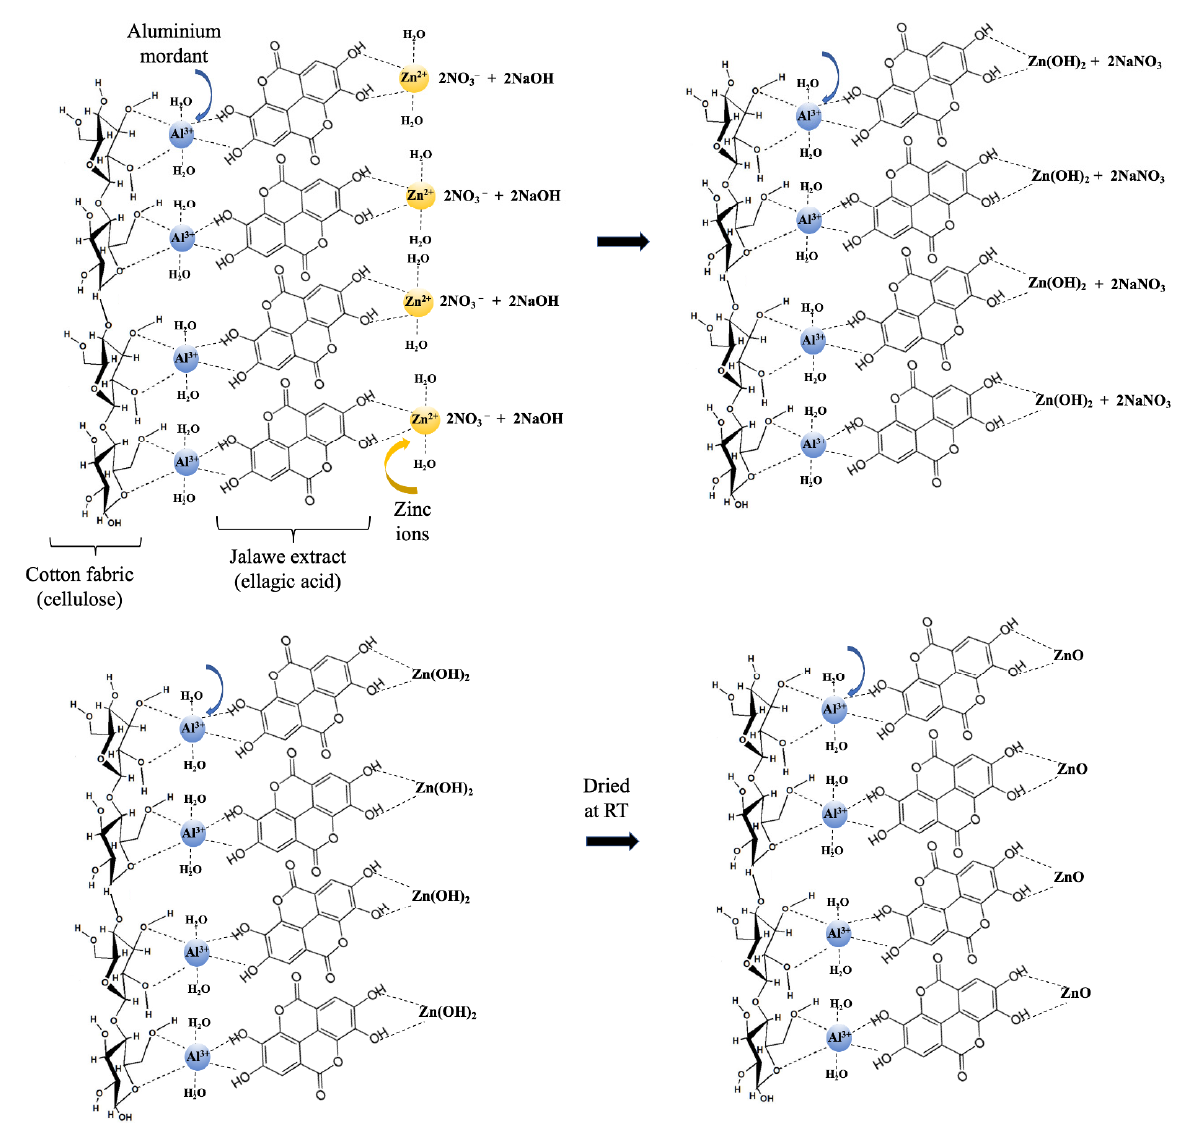
Figure 6. The chemical reaction pathways for the formation of ZnO NPs on ND-colored cotton fabric [42].